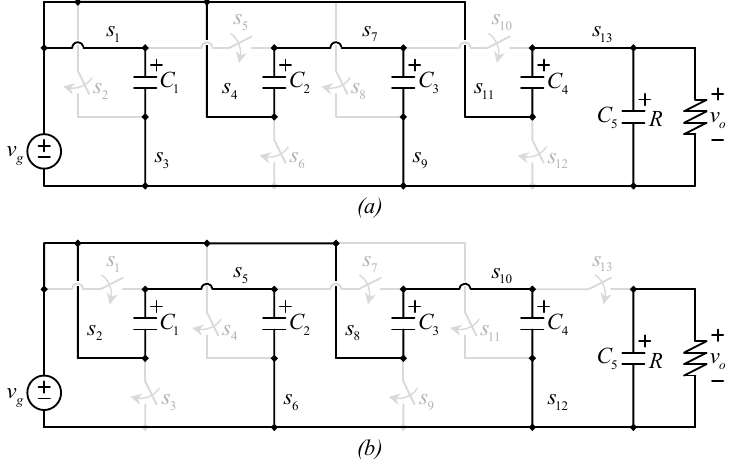
Figure 16. Equivalent circuits of the MMCC Converter , ( a ) first switching state, ( b ) second switching state.